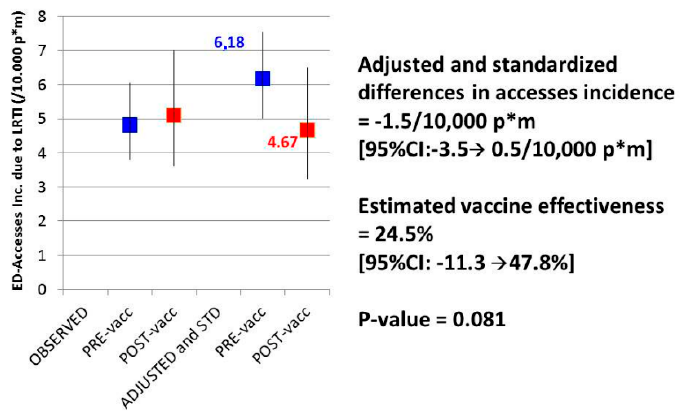
Figure 1. Observed and corrected incidences of Emergency Department (ED) accesses for lower respiratory tract infections (LRTI) before and after 13-valent pneumococcal conjugate vaccine (PCV13) immunization, in a cohort of 70–75 year-old Genoa inhabitants in 2010–2014.